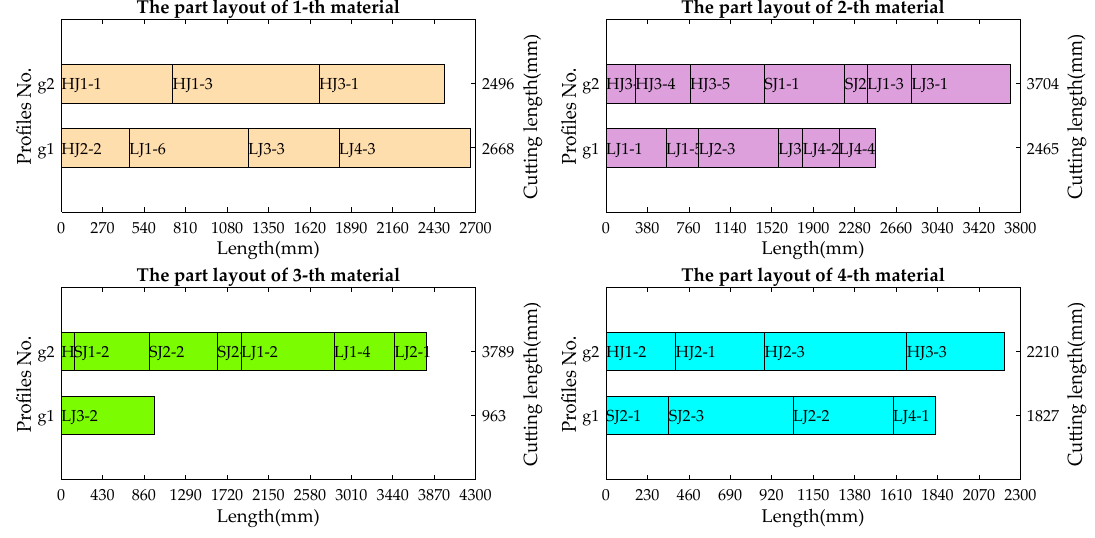
Figure 10. Gantt chart of optimal part nesting.